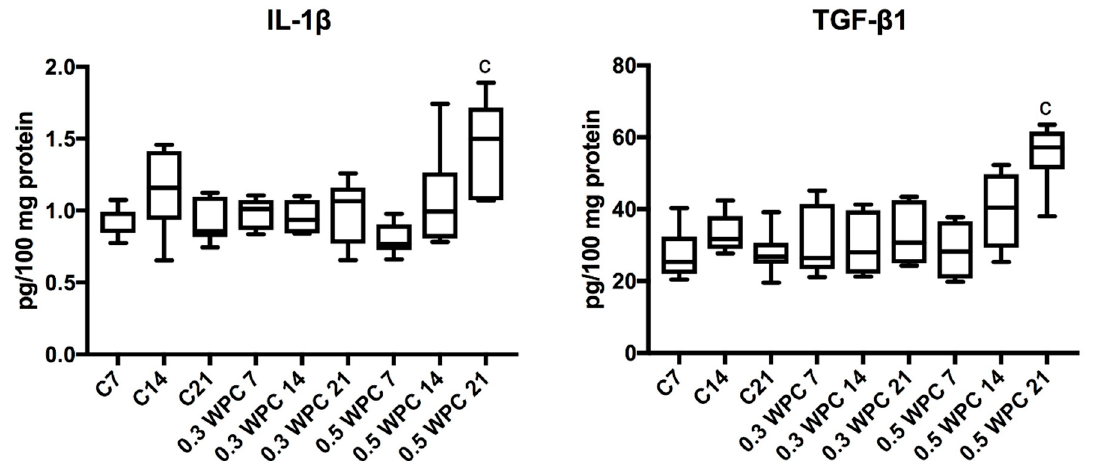
Figure 6. IL-1 β and TGF- β 1 levels in the liver of WPC-80-fed rats and the control group. C7, C14, C21, control groups; 0.3 WPC 7, 0.3 WPC 14, 0.3 WPC 21, 0.5 WPC 7, 0.5 WPC 14, 0.5 WPC 21, experimental groups. IL-1 β , interleukin-1 β ; TGF- β 1, transforming growth factor- β 1. Differences statistically important: c vs C21 ( p < 0.05).